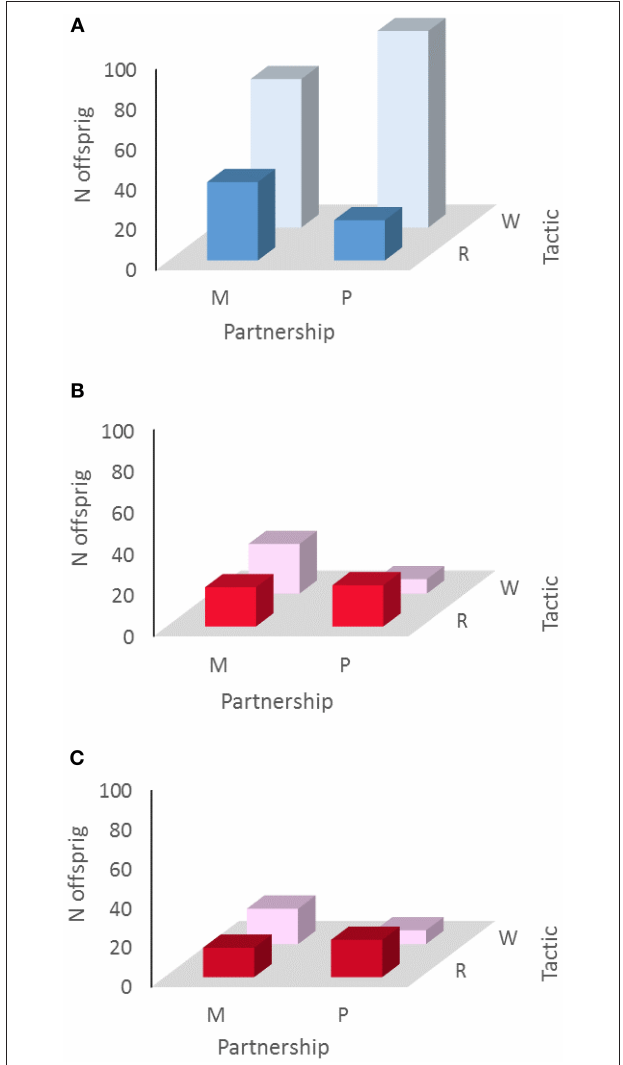
FIGURE 1 | Negative assortative mating has fitness consequences in male and in female prairie voles; (A) resident males (R) sired more offspring when in monogynous partnerships (M) than when in polygynous partnerships (P), and wanderer males (W) sired more offspring when in polygynous partnerships than when in monogynous partnerships, in each of the study locations (IN, KS) and when the data were pooled overall: residents; G = 9.48, P = 0.002, N = 231; (B) resident females (R) produced more offspring when in polyandrous partnerships (P) than when in monandrous partnerships (M) and wanderer females (W) produced more offspring when in polyandrous partnerships than when in monandrous partnerships, when KS samples were pooled across all sampling years; G = 6.19, P = 0.006, N = 70); (C) resident females (R) produced more offspring when in polyandrous partnerships (P) than when in monandrous partnerships (M) and wanderer females (W) produced more offspring when in polyandrous partnerships than when in monandrous partnerships, within the Indiana 2007 sample of females; G = 4.66, P = 0.031, N =